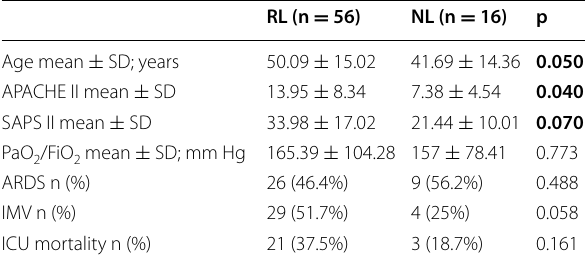
Table 1. Univariate analysis: Severity illness components according to